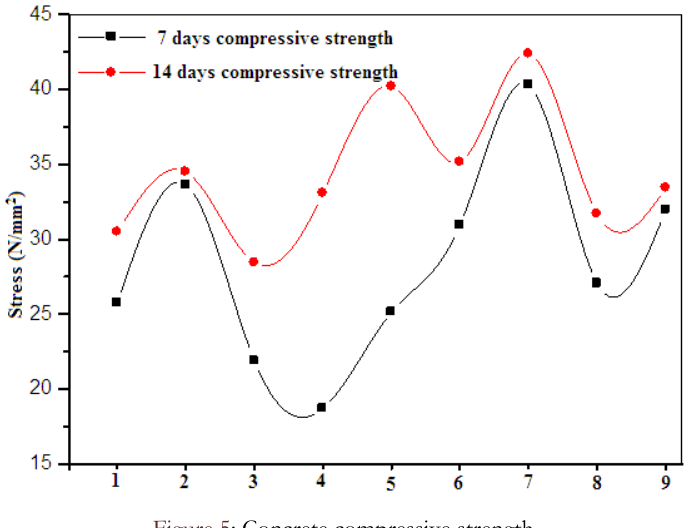
Figure 5: Concrete compressive